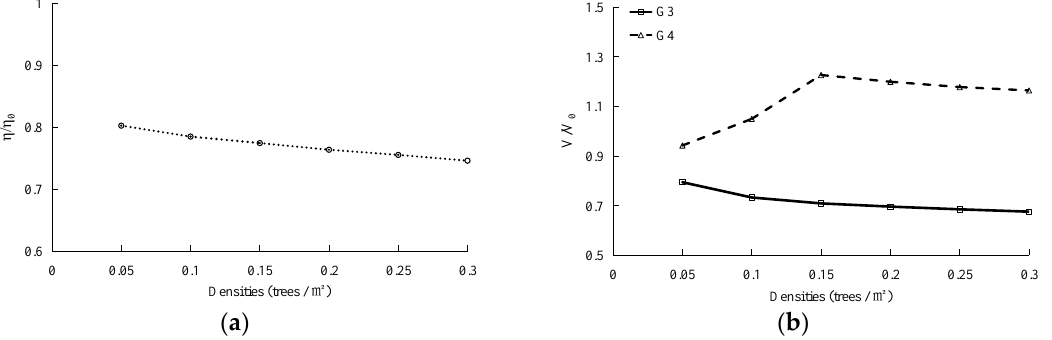
Figure 17. Variation of normalized run-up heights and normalized peak flow velocities at G3 and G4 with different tree collocations, ( a ) The normalized run-up heights, ( b ) The normalized peak flow velocities.